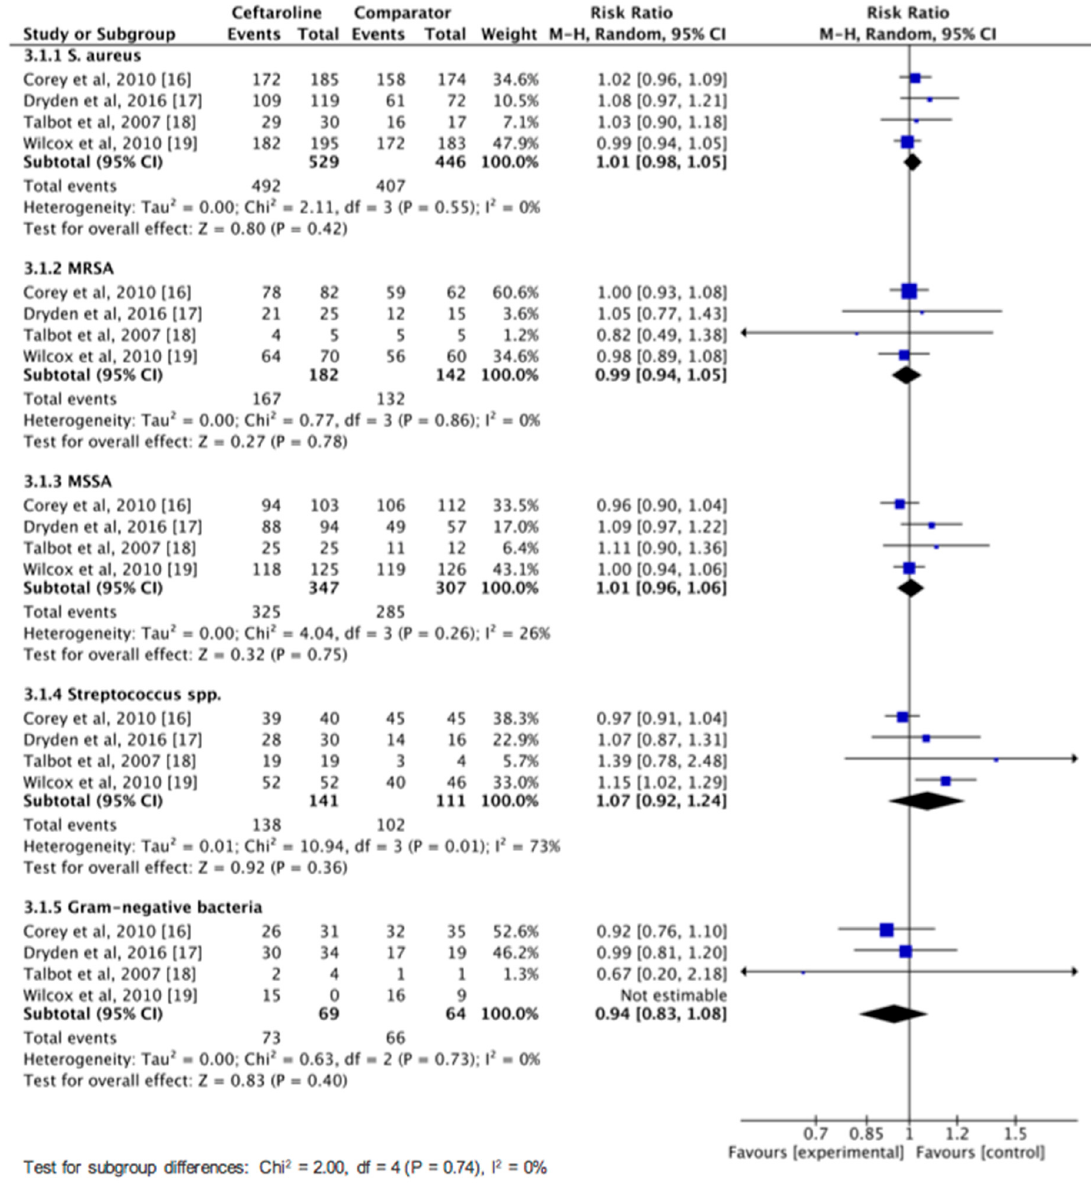
Figure 4. Overall clinical failure rates of ceftaroline and comparators in the treatment of complicated skin and soft tissue infections according to different pathogens. MRSA: methicillin-resistant Staphylococcus aureus : MSSA: methicillin-susceptible S. aureus.